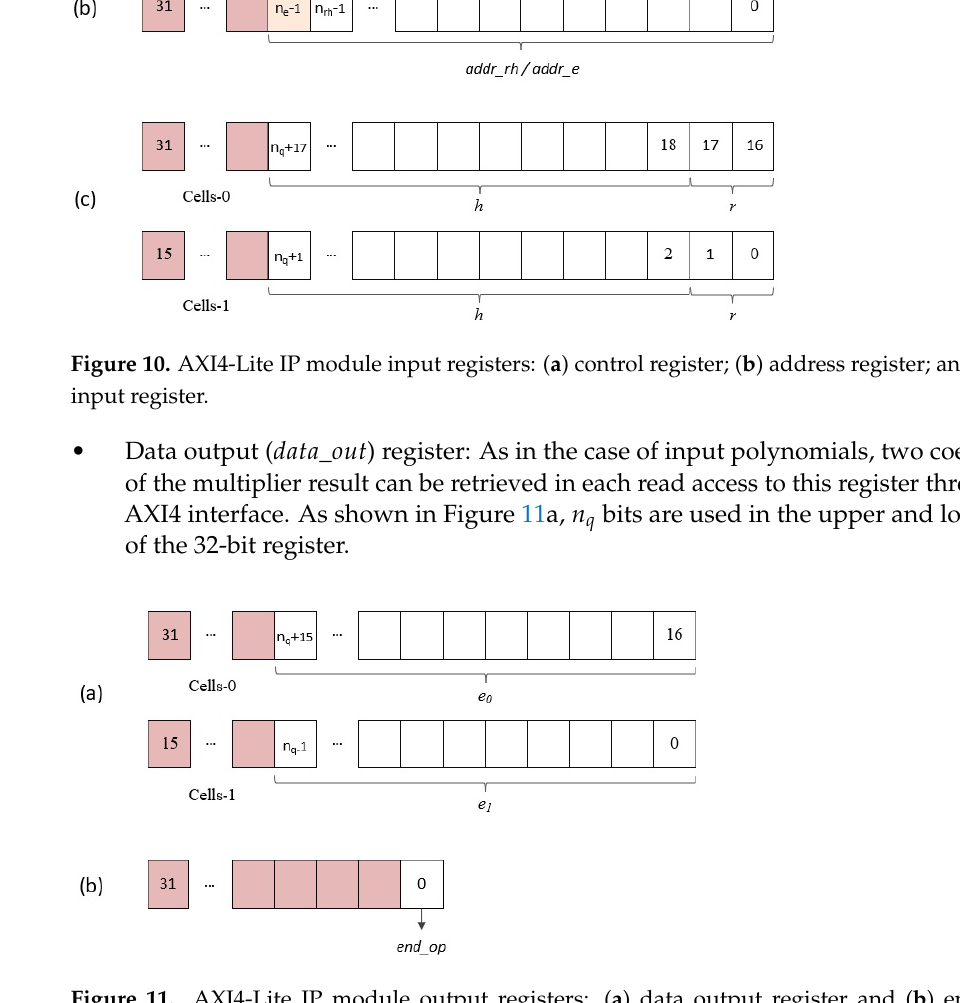
Figure 11. AXI4-Lite IP module output registers: ( a ) data output register and ( b ) end opera- tion